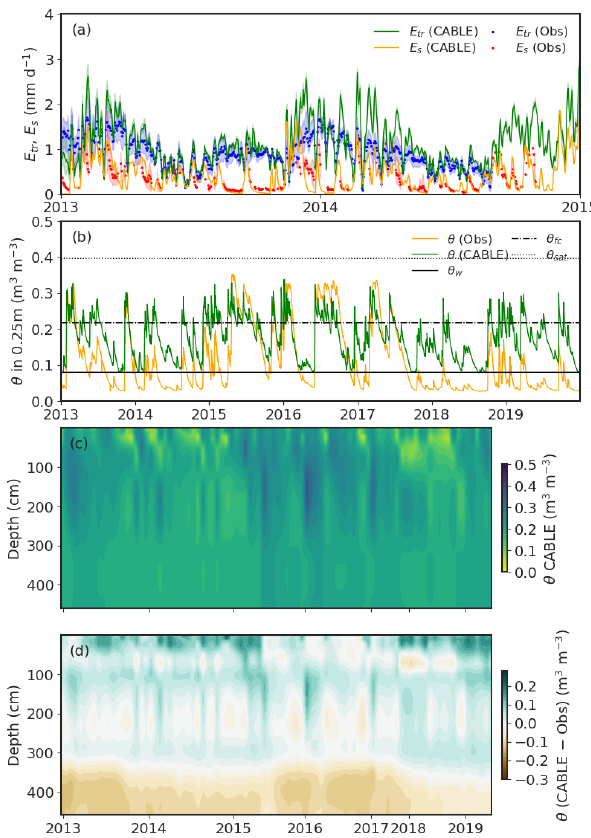
Figure 5. High-soil-resolution experiment (Hi-Res-2), which uses 31 soil layers with depth-varying hydraulic parameters informed by observed soil properties. (a) E tr and E s between 2013 and 2015. The shaded areas represent uncertainty between three ambi- ent rings. Both simulations and observations are smoothed with a 3d window to aid visualisation. (b) θ in the top 0.25m from 2013 to 2019. (c) The vertical distribution of θ in Hi-Res-2 at observed dates from 2013 to 2019. (d) θ difference between CABLE and ob- servations. Note the different time axis for panels (c–d) relative to panels (a–b) due to different sampling intervals for soil moisture and